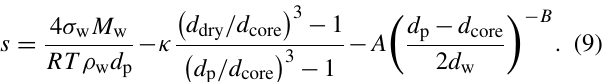
Figure 2. Effective density of the pure BC particles for different mobility diameters. The fitted fractal dimension is